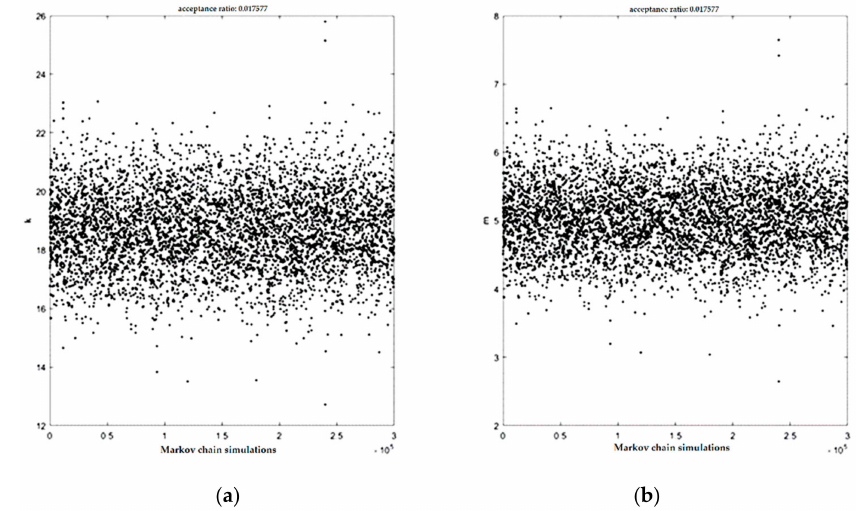
Figure 5. Markov Chain Simulation for: ( a ) k ; ( b ) m